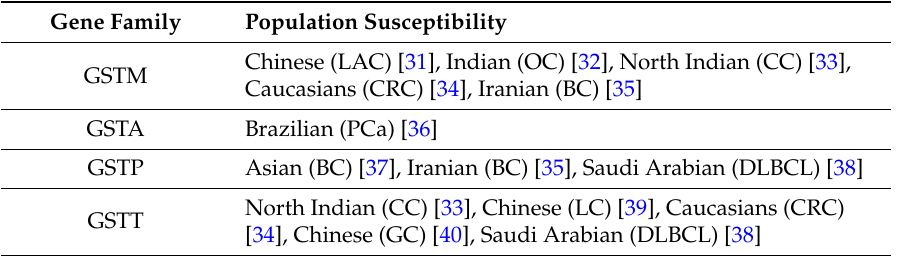
Table 2. Population susceptibility for different diseases related to major types of